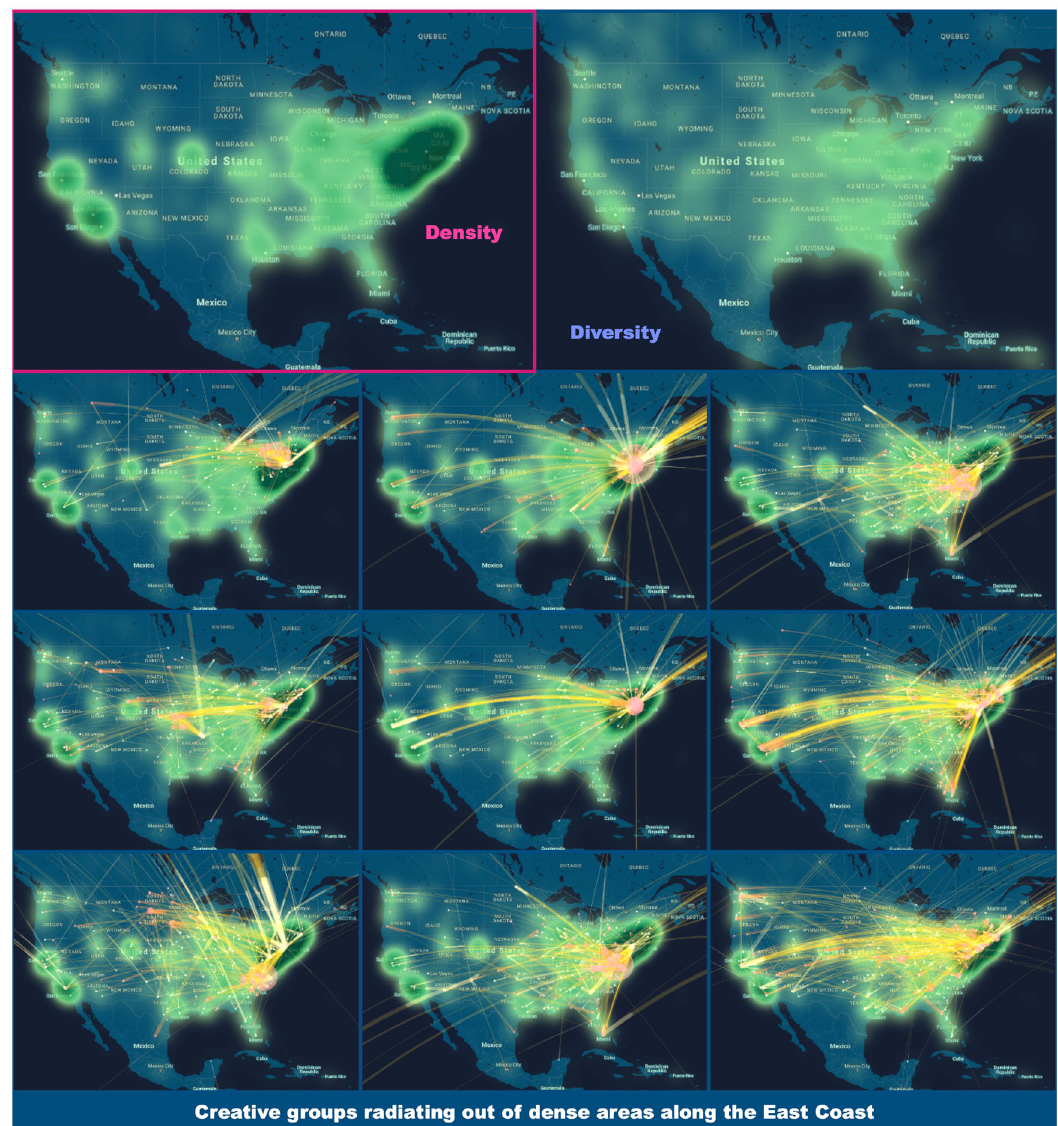
Fig. 3 Diversity radiates out of centers of density in urban environments. The heat map on the top left — framed pink and labeled Density — represents the geographical coverage of US-news that contains the term “ science ” . In such “ science-news ” , journalists most frequently write about institutions, infrastructures, and places that are located along the East Coast (most prominently around New York). Hence, high density is found there. Almost equally featured in the science-news are the metropolitan areas of Los Angeles and San Francisco. The data used in the density map can be analyzed and split into multiple creative groups of news. A sample set of nine such groups is displayed below, labeled Creative groups . These particular nine groups were chosen among 300 as examples of creative groups that radiate out of the dense zone along the East Coast. The map labeled Diversity is a diversity map created by calculating Simpson ’ s diversity index on all 300 creative groups. The highest levels of diversity are found in the centers of density located along the